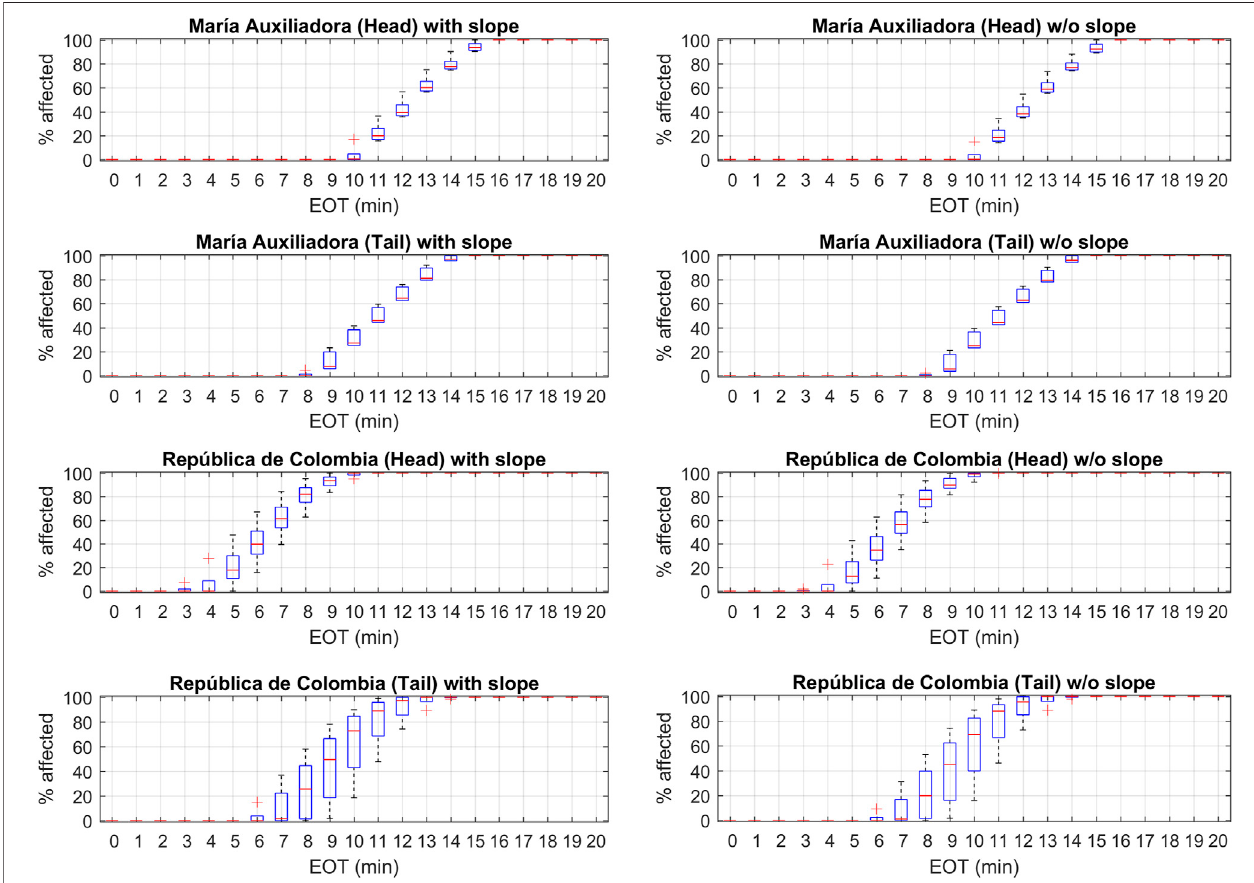
FIGURE 8 | Box plots showing the percentage of affected evacuees of the MA and RC schools in Viña del Mar, for evacuation speeds v1 to v5.